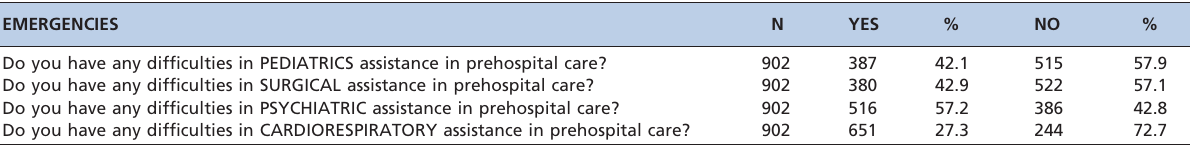
Table 2 - General skills in emergency